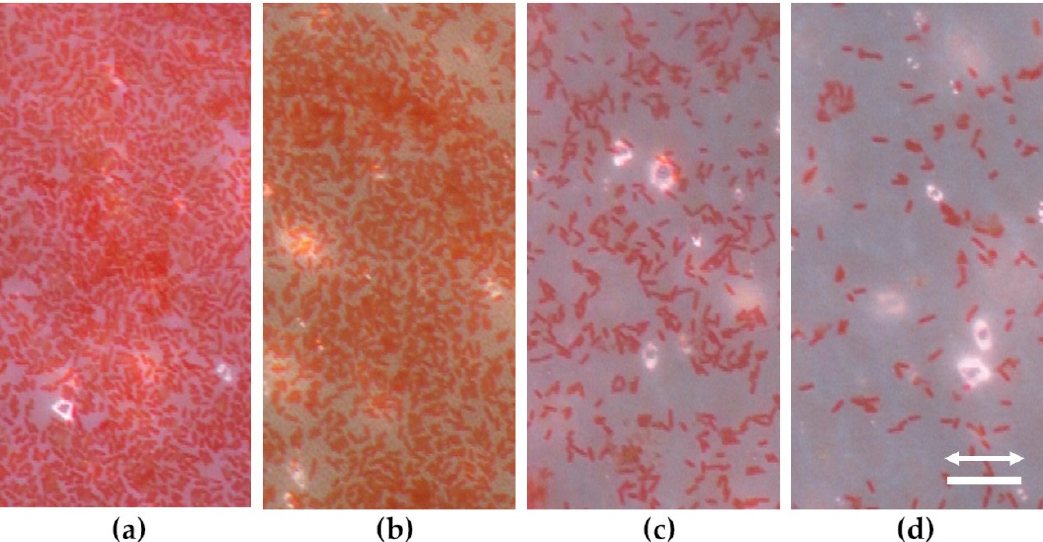
Figure 5. Top-view optical reflected light microscopy of Safranine-stained E. coli TG1 on PET foils: ( a ) non-irradiated PET (flat reference); ( b ) laser-irradiated at θ = 60°; ( c ) θ = 30°; ( d ) θ = 0°, resulting in LIPSS periods of 613 nm, 331 nm and 214 nm, respectively. For detailed laser processing parameters see also Figure 2. Scale bar 10 µm. The arrow indicates horizontal LIPSS orientation in ( b – d ).